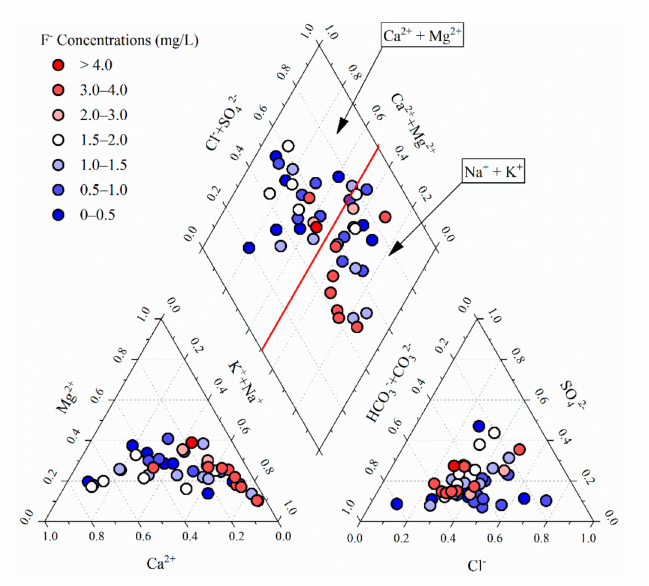
Figure 6. Influence of hydrochemical conditions on fluoride in groundwater of the Jiaolai Basin.